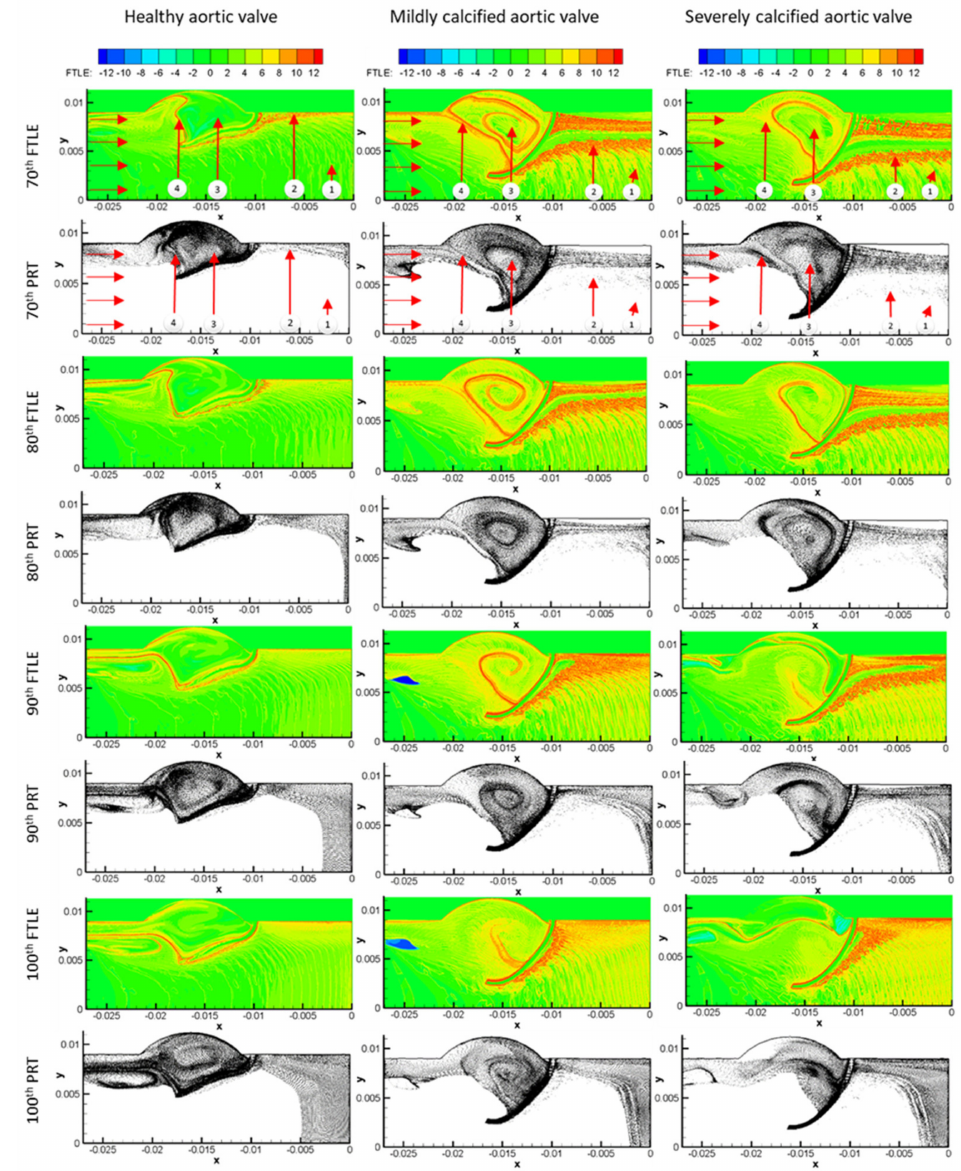
Figure 5. Forward finite-time Lyapunov exponent (FTLE) field plots of healthy ( first column ), mildly calcified ( second column ), and severely calcified ( third column ) aortic